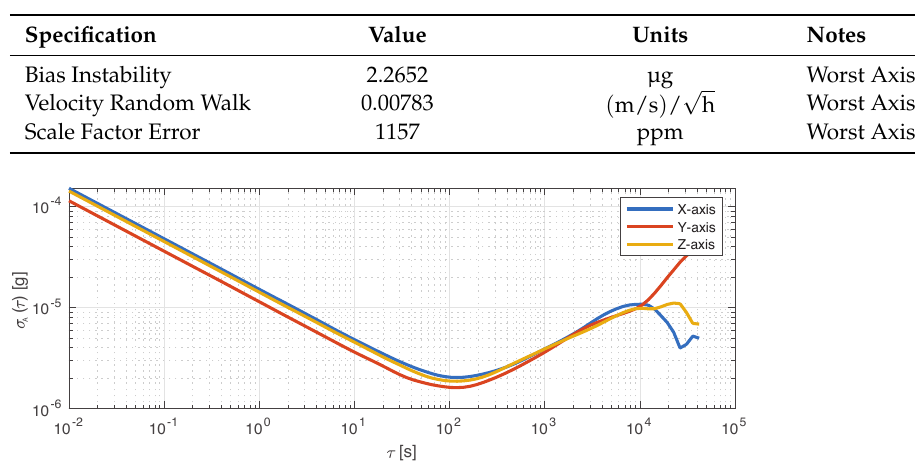
Table 8. Memsense MS3025M accelerometer specifications.